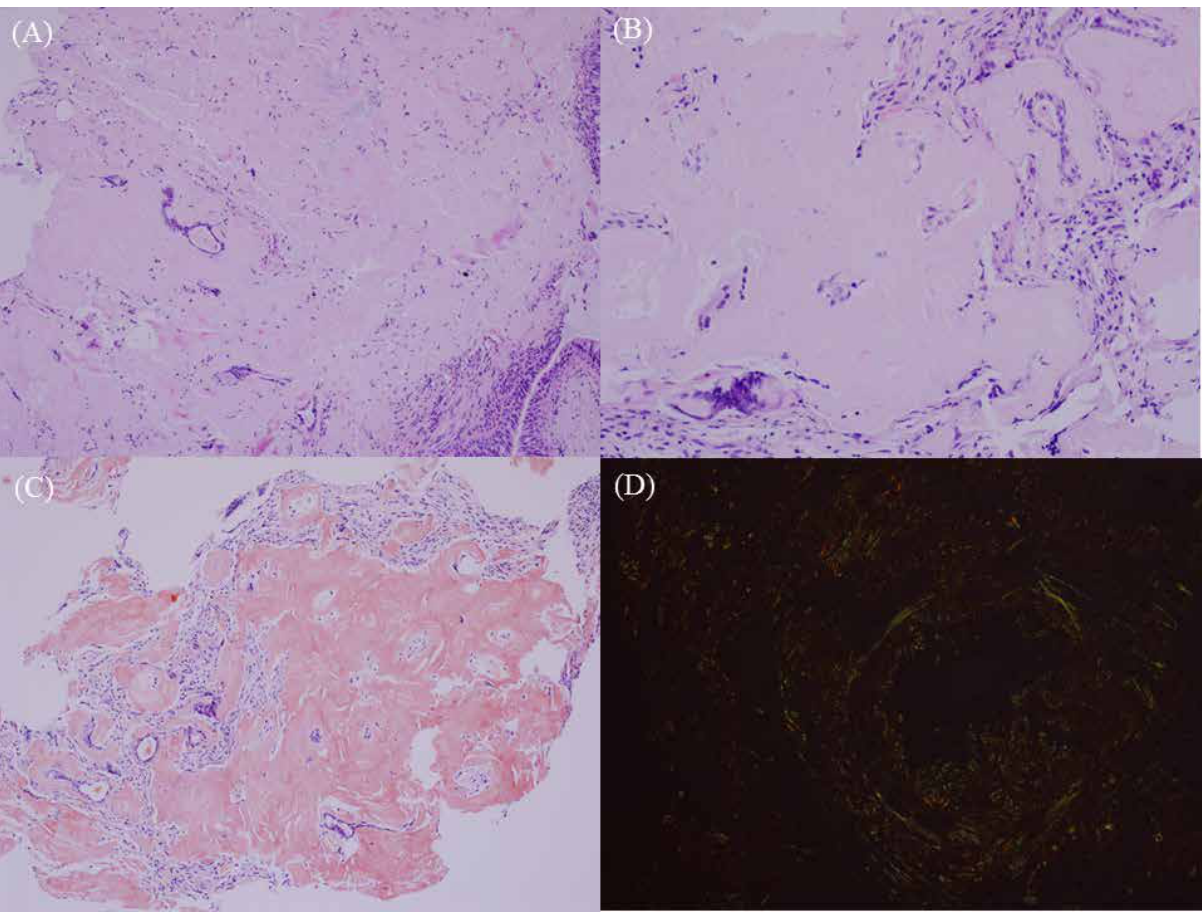
Figure 3: Pathologic findings. (A) The bronchoscopic tissue shows an amorphous material deposit in endobronchial area (X40). (B) The pinkish material is associated with multinucleated giant cells (X100). (C) The material shows a red color at Congo-red stain (X20). (D) These deposits exhibit a green birefrin- gence under polarized microscopy on Congo red stain